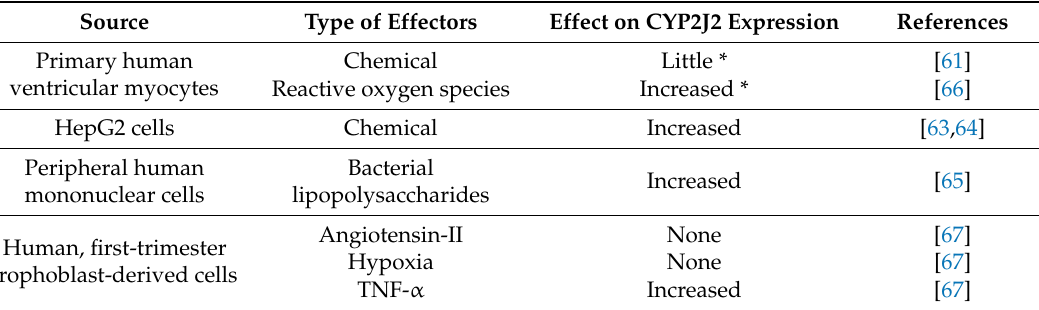
Table 2. Summary of CYP2J2 expression by some effectors in various cell